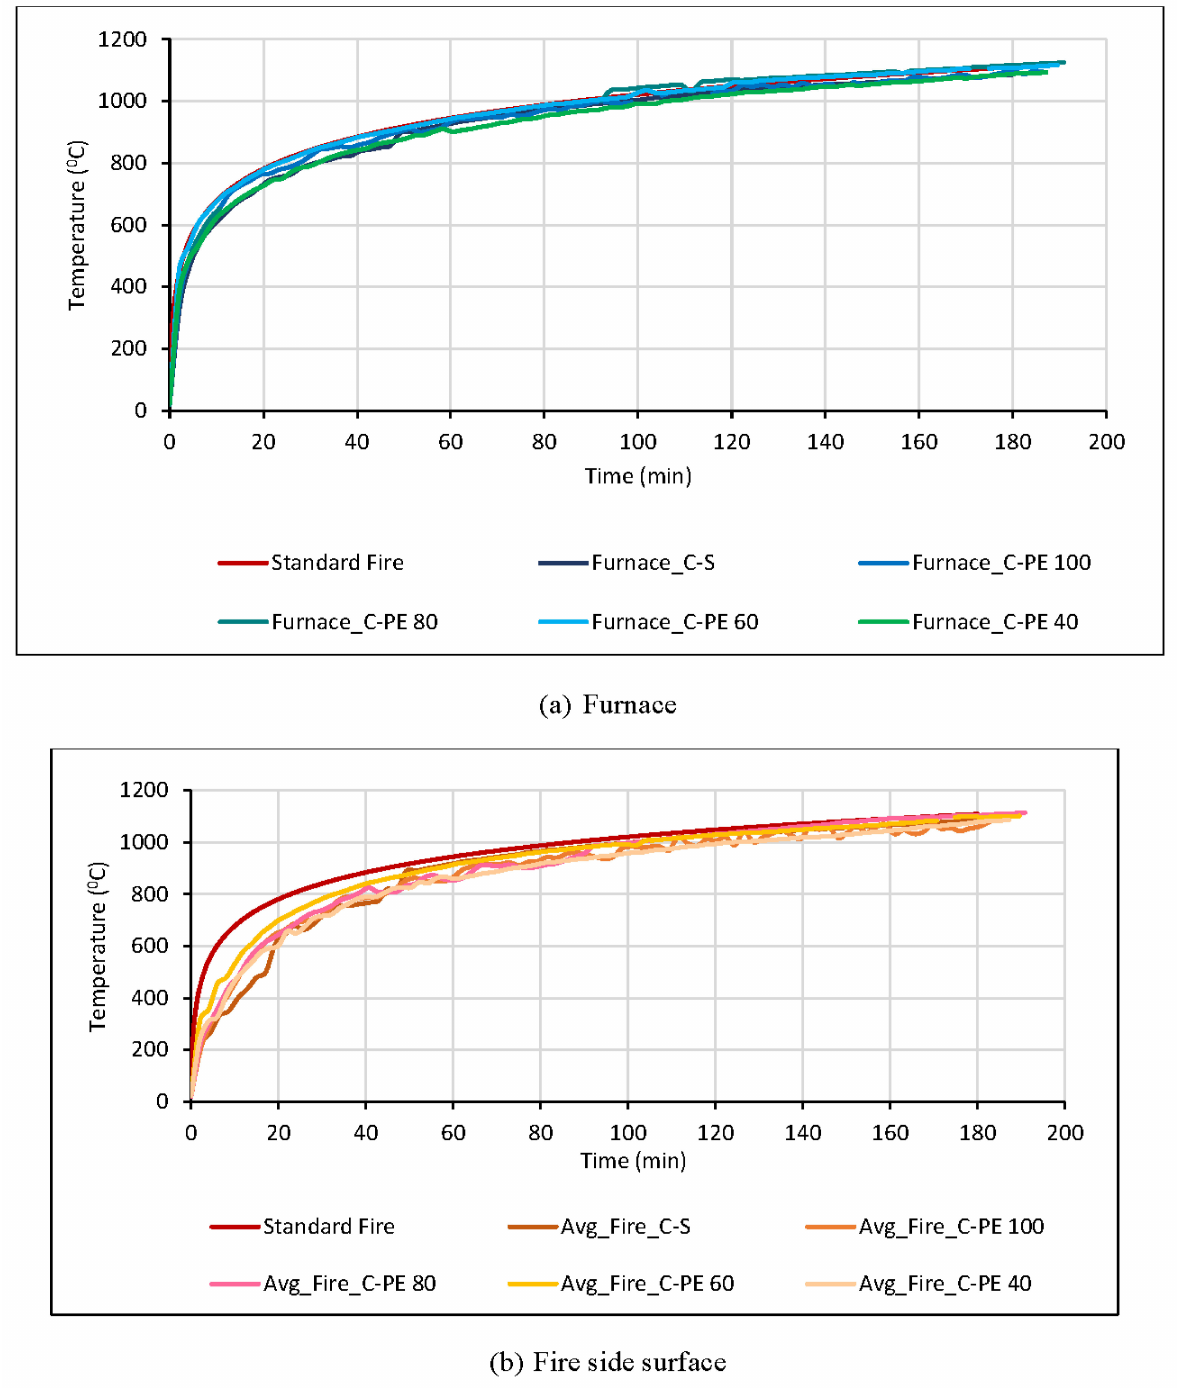
Figure 29. Time–temperature curves of C-PE blocks from the building fire